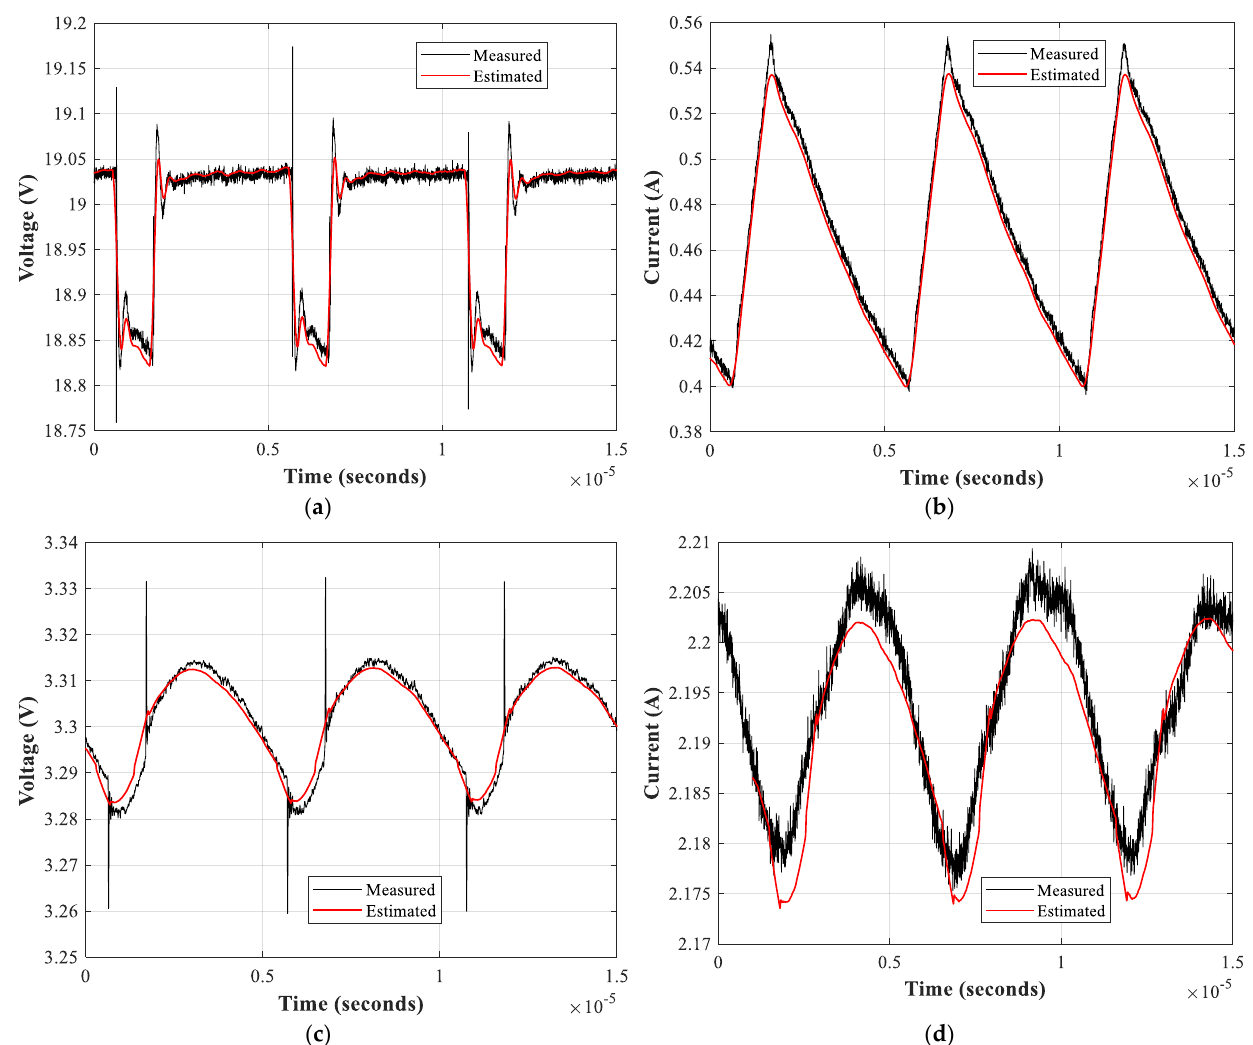
Figure 13. Measured signals versus the estimated ones with the CNN-LSTM NN. ( a ) Input voltage; ( b ) Input current; ( c ) Output voltage; ( d ) Output voltage.